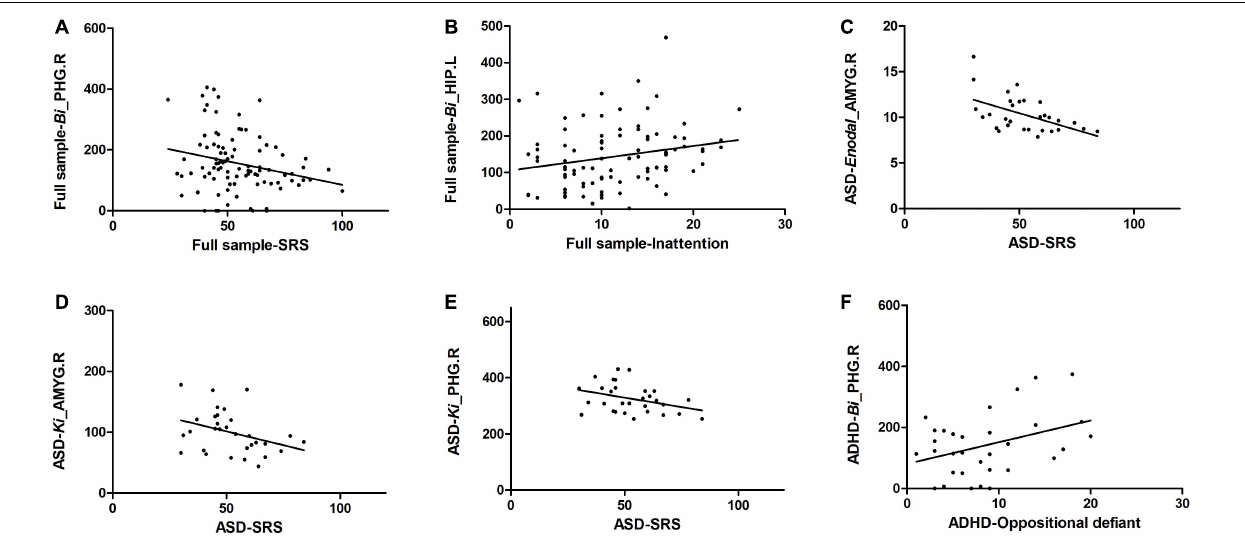
FIGURE 4 | Significant correlation of altered regional properties with ASD and ADHD traits. (A) Bi of the PHG.R was significantly correlated with SRS scores in the full sample; (B) Bi of the HIP.L was significantly correlated with inattention subscale scores of the SNAP-IV in the full sample; (C) Enodal of the AMYG.R was significantly correlated with SRS scores in the ASD group; (D) Ki of the AMYG.R was significantly correlated with SRS scores in the ASD group; (E) Ki of the PHG.R was significantly correlated with SRS scores in the ASD group, and (F) Bi of the PHG.R was significantly correlated with oppositional defiance subscale scores of the SNAP-IV in the ADHD